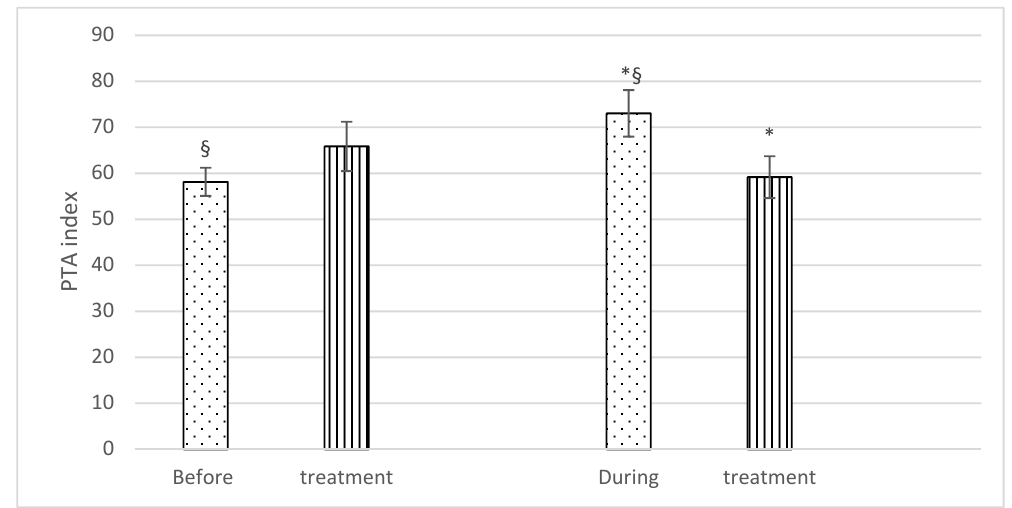
Figure 1. EtIso% and extra ketamine (mg/kg) before and during treatment (fentanyl dots, control stripes). p < 0.05. * = significantly different between groups; § = significantly different before and during treatment.